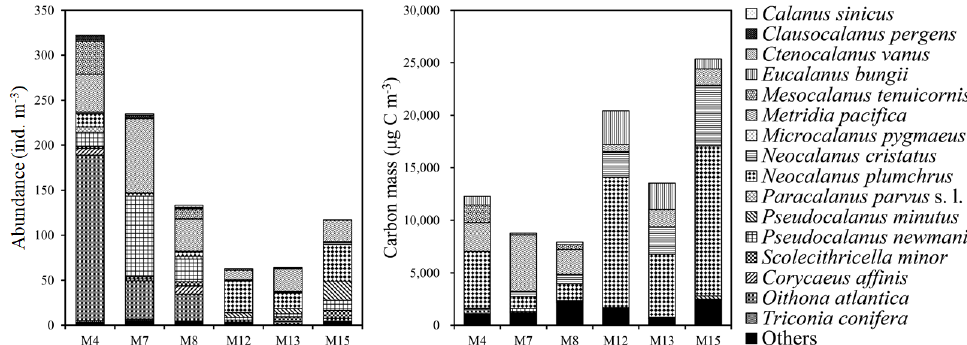
Figure 3. Copepod abundances (individuals (ind.) m − 3 ) and carbon masses in the south (M4 – M7) and north regions (M12 – M15) of the subpolar front.